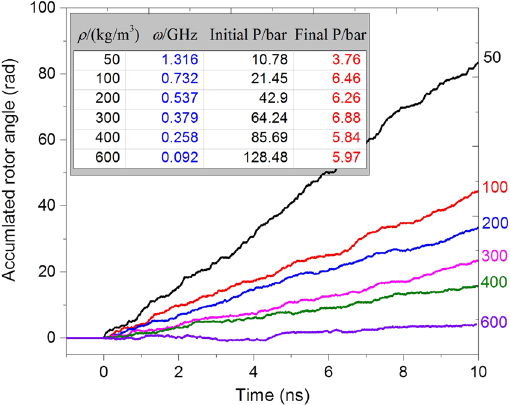
Figure 8. Histories of the accumulated rotor angles in the box with l = 8 and with different argon densities. The other three quantities, i.e., time averaged rotational frequency of the rotor, initial and final pressure (P) of the box, are given in the inserted